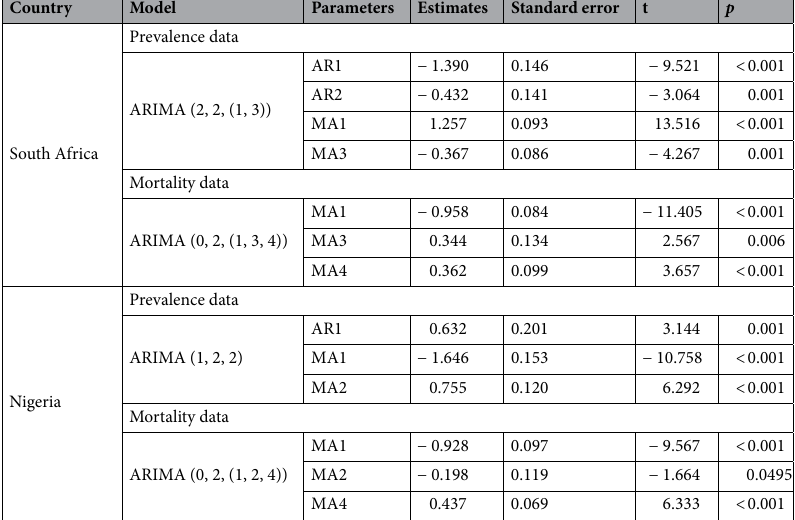
Table 2. The identified parameters of the best-fitting ARIMA models for the prevalence and mortality time series of COVID-19 in South Africa and Nigeria. ARIMA Autoregressive integrated moving average method, AR autoregressive method, MA moving average